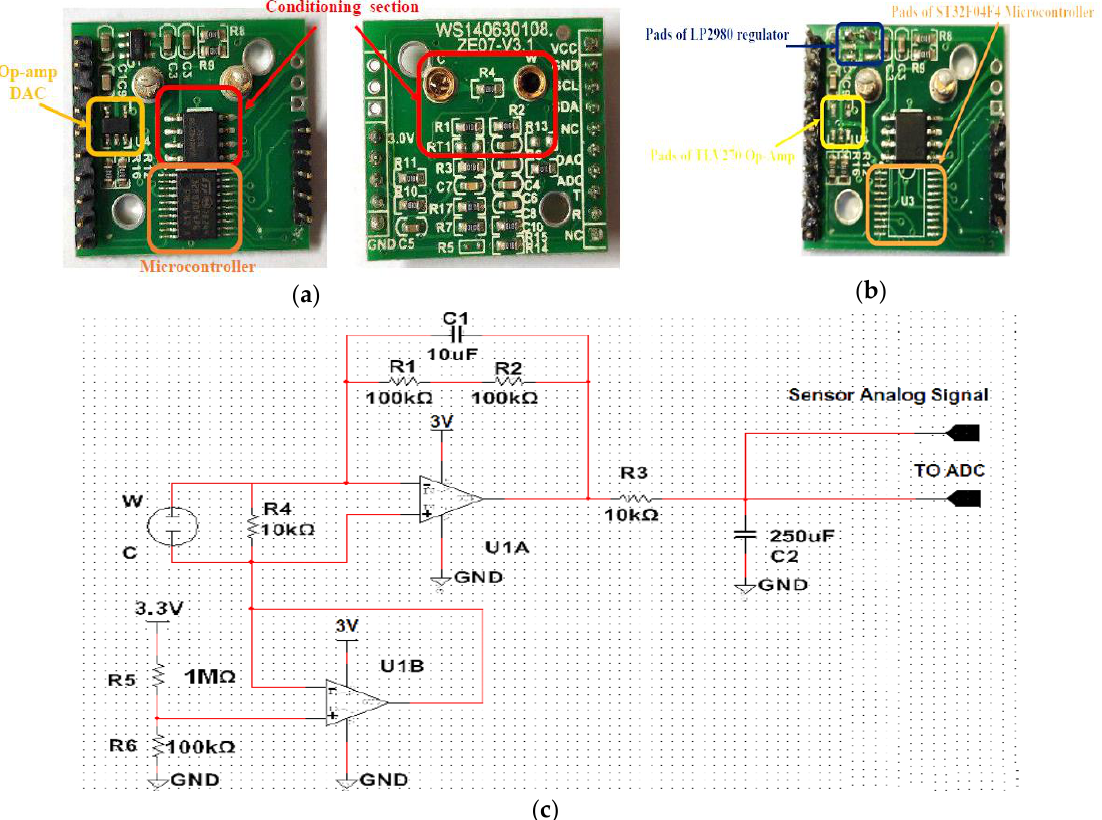
Figure 21. Top and bottom view ( a ) of the ZE07-CO (Winsen Inc.) conditioning board before the modification, and after the modification aimed to reduce the power consumption ( b ); schematic of the conditioning unit ( c ).